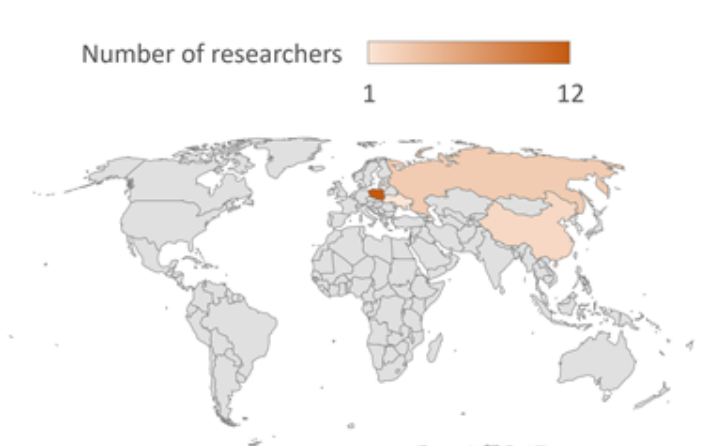
Figure 2. Authors’ countries.